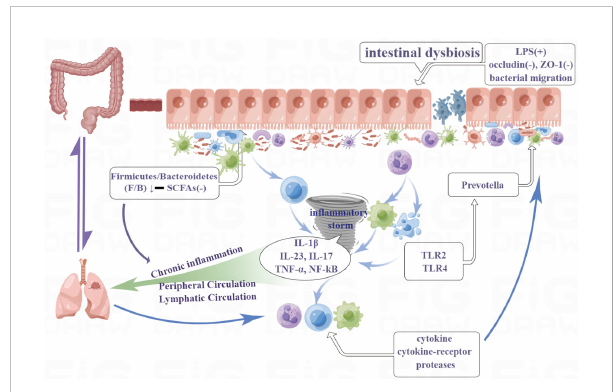
FIGURE 2 The lungs and large intestine can work together to modulate immunity and in fl ammation through the lung-gut axis, in which the movement of the gut microbiota and metabolites is the most important communication mechanism. Moreover, they are indirectly connected via the circulatory and lymphatic